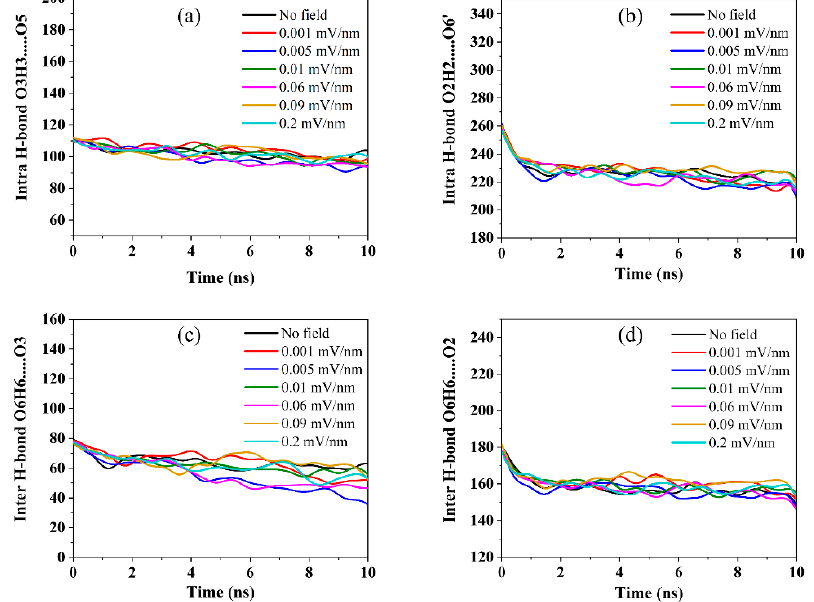
Figure 4. Hydrogen bond population (electric field along the z-axis) ( a ) intrachain O3H3…..O5, ( b ) intrachain O2H2…..O6’, ( c ) interchain O6H6…..O3 and ( d ) interchain